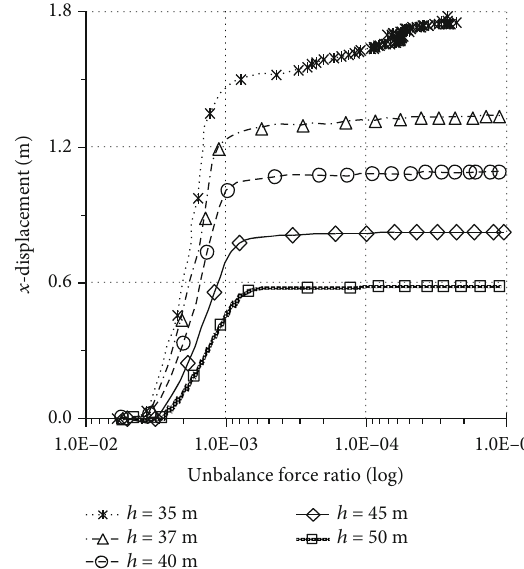
Figure 13: Relationship between displacement of node O in x -direction and unbalanced force rate ( b = 0 : 5